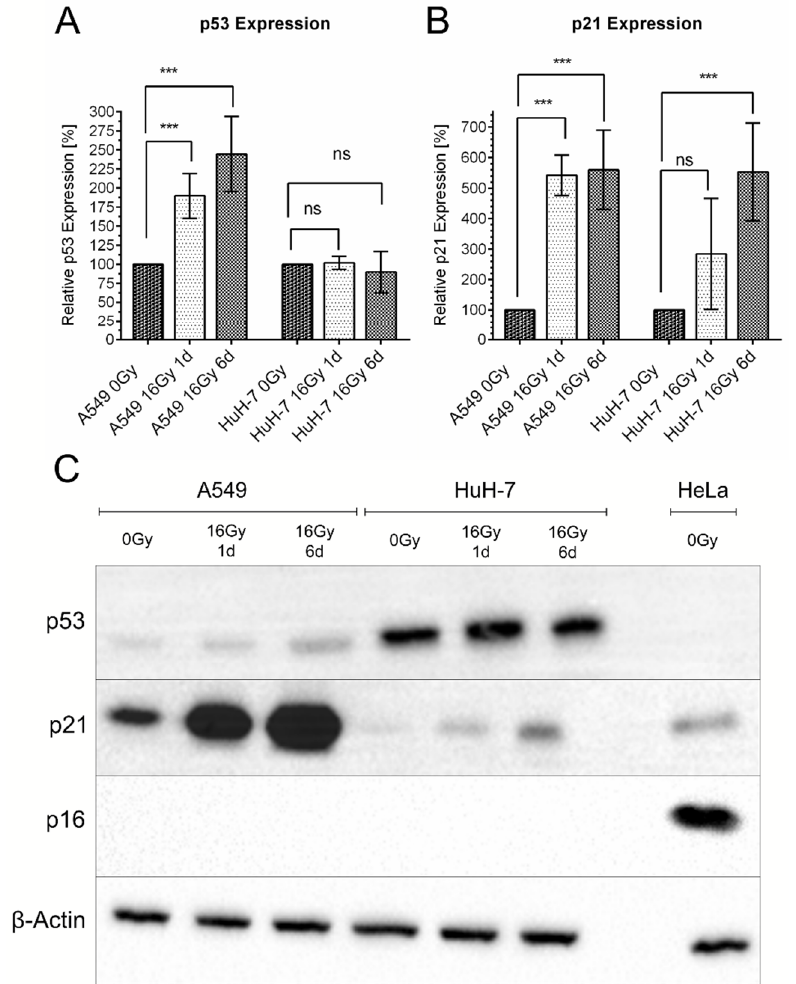
Figure 8. Expression levels of p16, p53, and p21 in A549 and HuH-7 cells after irradiation. The relative expression of p53 increased significantly in A549 cells after irradiation. In contrast, in HuH-7 cells, p53 expression remained at a consistently very high level ( A ). Following irradiation, the expression of p21 increased in both cell lines under investigation, in A549 cells faster (already on day one after irradiation) than in HuH-7 cells ( B ). There was no detectable p16 expression in A549 and HuH-7 cells at all time points and under all treatments under investigation. In ( C ), a representative Western blot is shown, showing expression of p53, p21, p16, and β -actin. The latter served as non-regulated reference protein. HeLa cells served as p16 positive control. Shown are mean values ± SD, the relative expression of each protein studied is expressed with respect to the non-regulated reference protein β -actin and related to the non-irradiated control sample (=100%) of the corresponding cell line. Two-way ANOVA, comparison between untreated control cells and irradiated cells at day one (1 d) and day 6 (6 d) of the respective cell line, correction for multiple comparisons by Bonferroni, N ≥ 4, *** p < 0.001, ns = not significant.